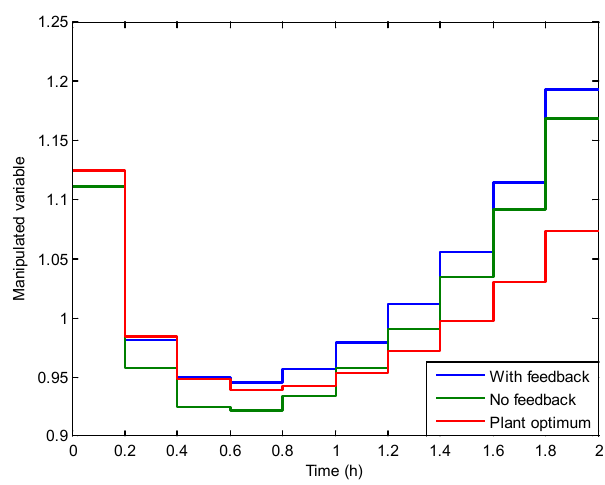
Figure 1. Input for Case 1, with perturbation in